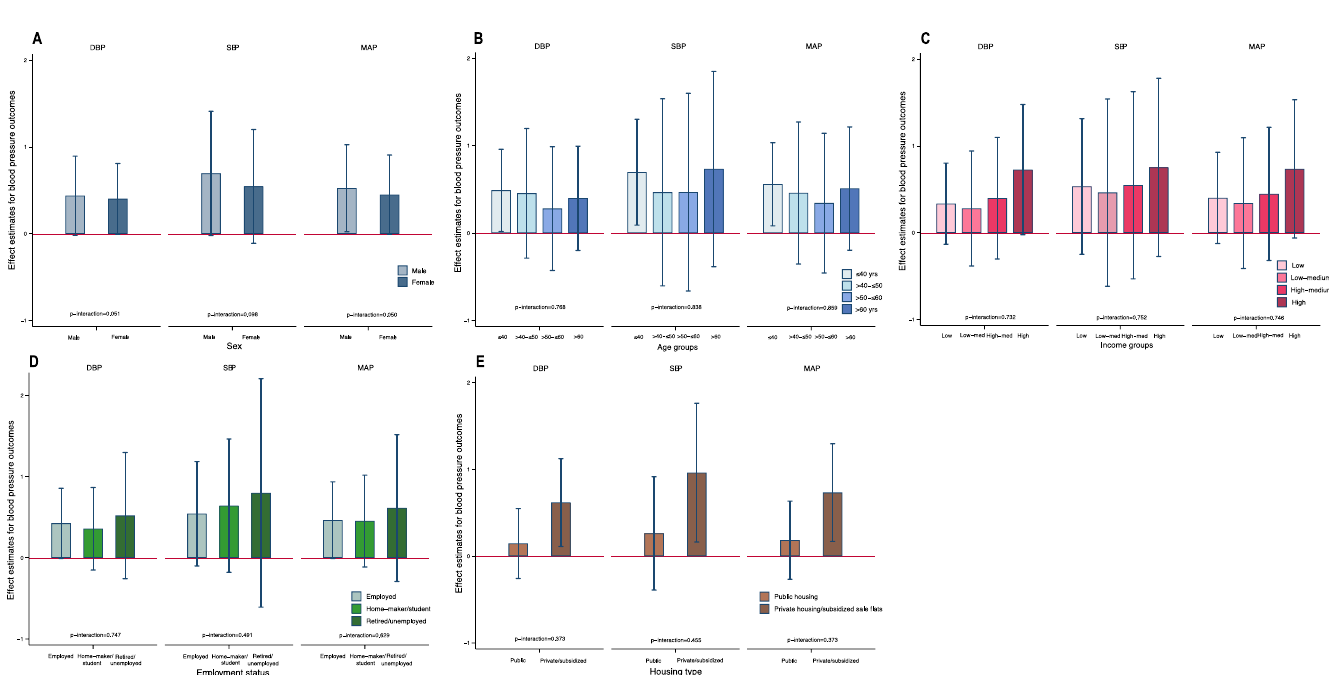
Fig 2. Association between residential units per block and blood pressure outcomes by (A) sex, (B) age groups, (C) income categories, (D) employment status, and (E) housing type in the second wave of FAMILY Cohort. Models adjusted for sociodemographics (age, sex, marital status, employment status, educational attainment, and income), lifestyle (smoking status, alcohol intake frequency, number of family members, shared living, and housing type), comorbidities (obesity and cardiac heart disease), and environment (liveable floor area, neighborhood-level residential density, housing floor level, and density of public transport and terrain). The vertical bars indicate the effect estimate ( β ), while the whiskers indicate 95% CI. The p -values are for the interactions between residential units per block and population subgroups stratified by sex, age, income, employment status, and housing type. β , beta; CI, confidence interval; DBP, diastolic blood pressure; MAP, mean arterial pressure; SBP, systolic blood pressure.